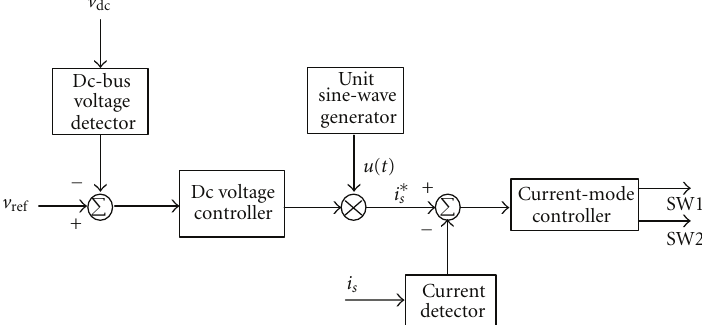
Figure 5: A block diagram of the system